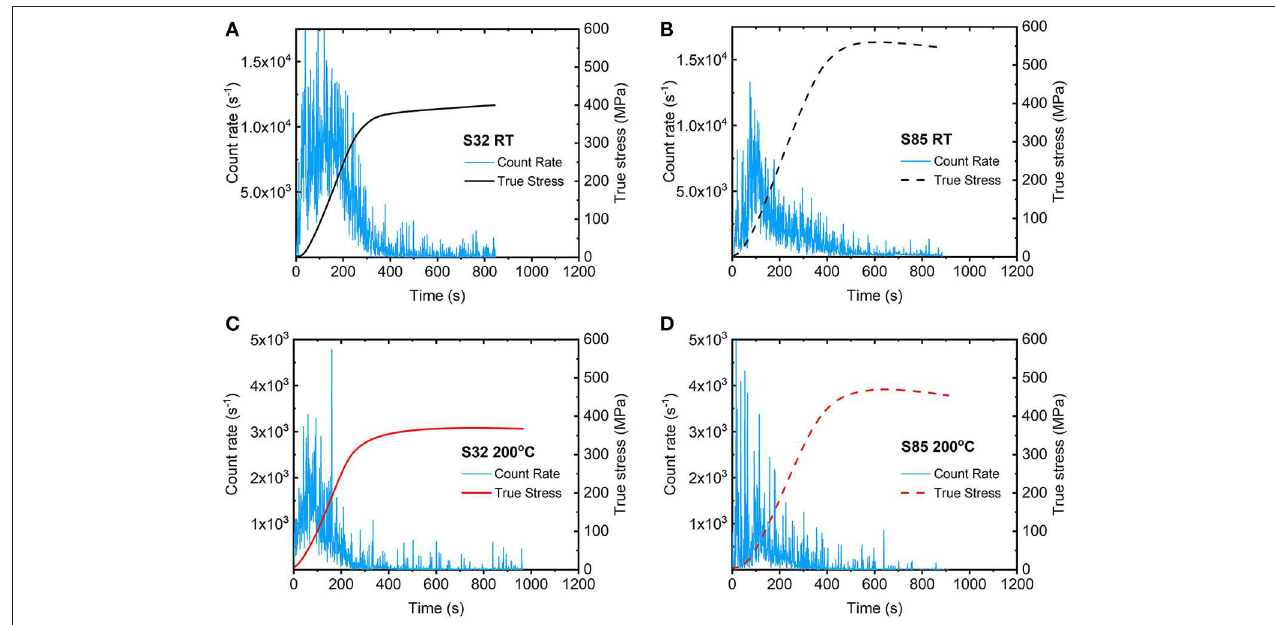
FIGURE 5 | The evolution of the AE count rate with time during compression loading of the S32 and S85 alloys at RT (A,B) and at 200 ◦ C ( C,D , respectively).